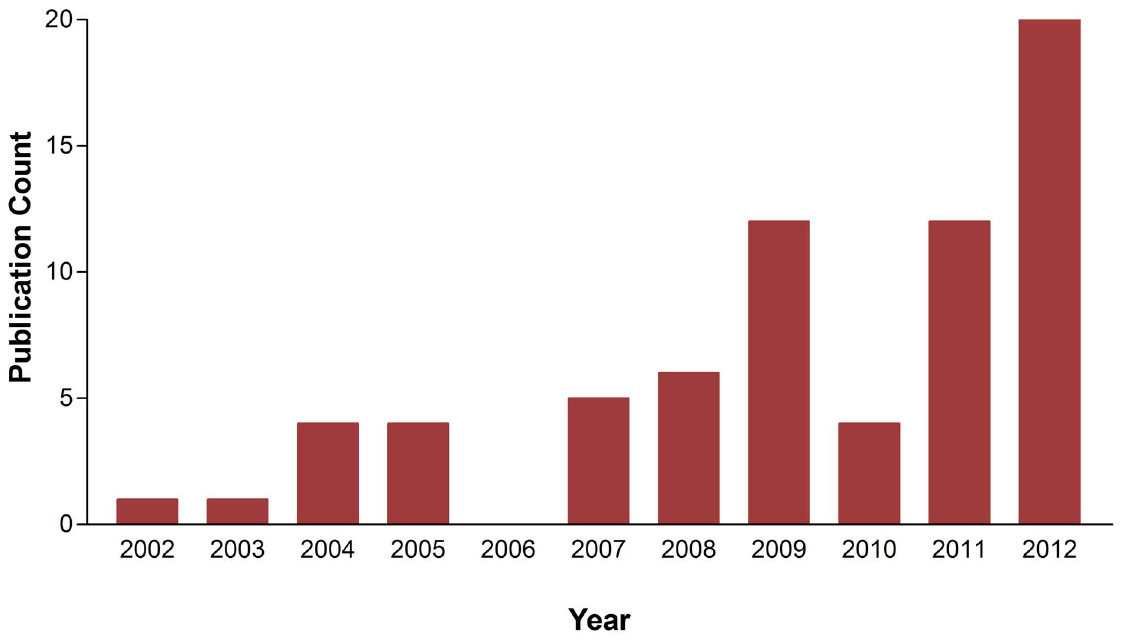
Figure 1. Bioinformatics-related publications per year by Nigerian scientists. The search terms ‘‘bioinformatics Nigeria,’’ ‘‘in silico Nigeria,’’ ‘‘computational biology Nigeria,’’ and ‘‘next generation sequencing Nigeria’’ were used to retrieve publications from the PubMed, Web of Science, and Scopus databases over the period of 2002 to 2012.